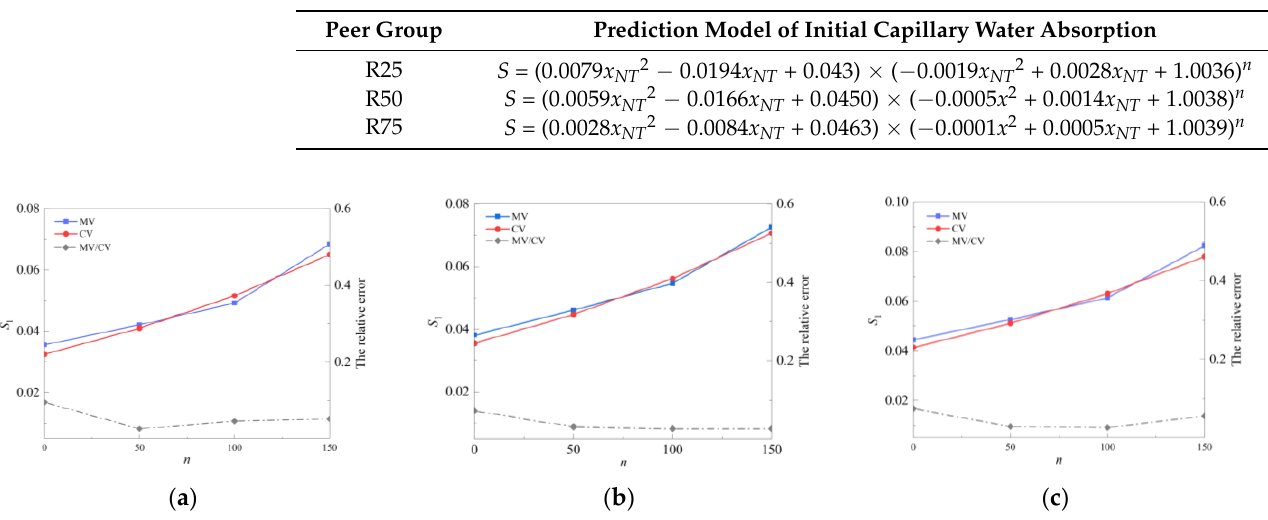
Table 10. Prediction model of initial capillary water absorption of Nano-TiO 2 recycled aggregate concrete.